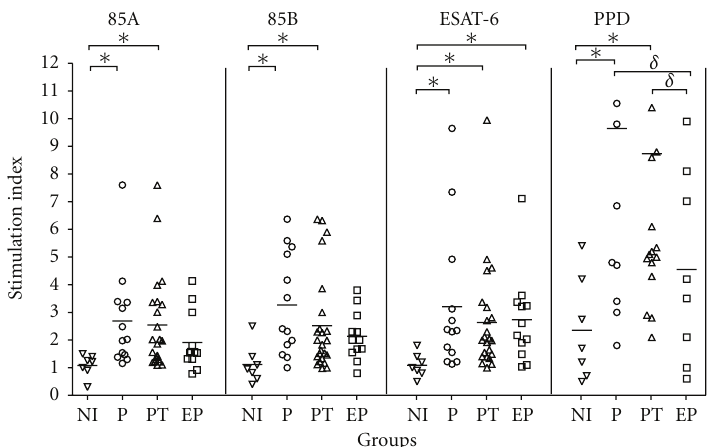
Figure 3: Lymphocyte proliferation in response to recombinant Ag85A, Ag85B and ESAT-6. Freshly isolated PBMC from non-infected individuals (NI), pulmonary TB patients (P), pulmonary TB patients in treatment (PT) and extra-pulmonary TB (EP) were cultured in the presence of Ag85A (25 μ g/ml), 85B (25 μ g/ml), PPD (25 μ g/ml) or ESAT-6 (50 μ g/ml) for 5 days and incorporation of [ 3 H] thymidine was measured. Results are expressed as stimulation index (SI) mean of triplicate cultures. Horizontal bars indicate mean values. Di ff erences between responses from TB patient groups and control groups were analyzed with nonparametric Kruskall-Wallis test. ( ∗ ) Statistically significant di ff erences in relation to NI group and ( δ ) in relation to EP group ( P < .